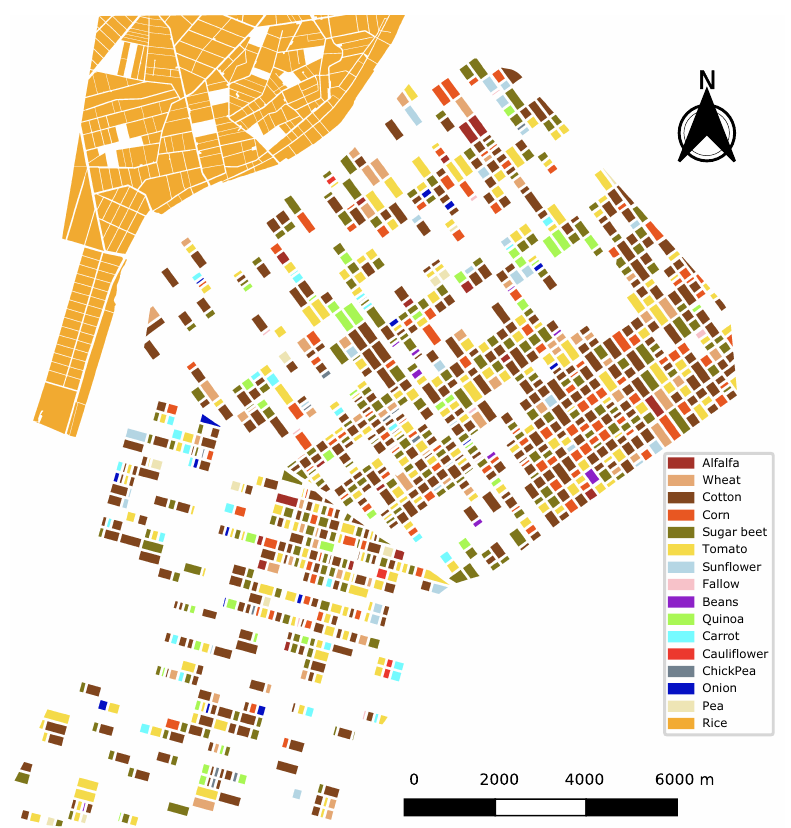
Figure 1. Crop-type map with all fields available in the reference data. Table 1. Table of number of fields and total area per crop type in the study